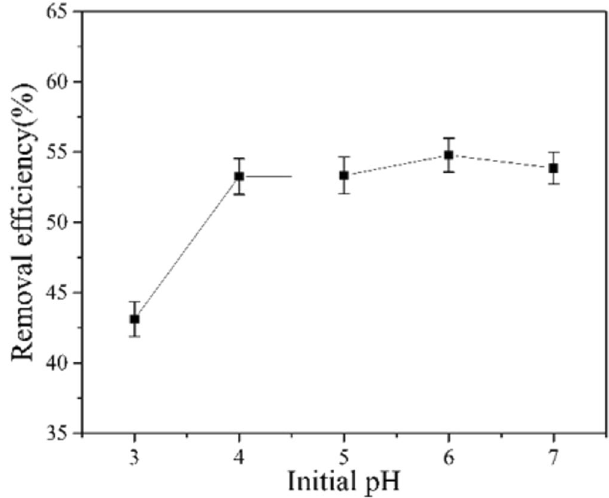
Figure 7. Effect of pH on adsorption efficiency of Mn(II).